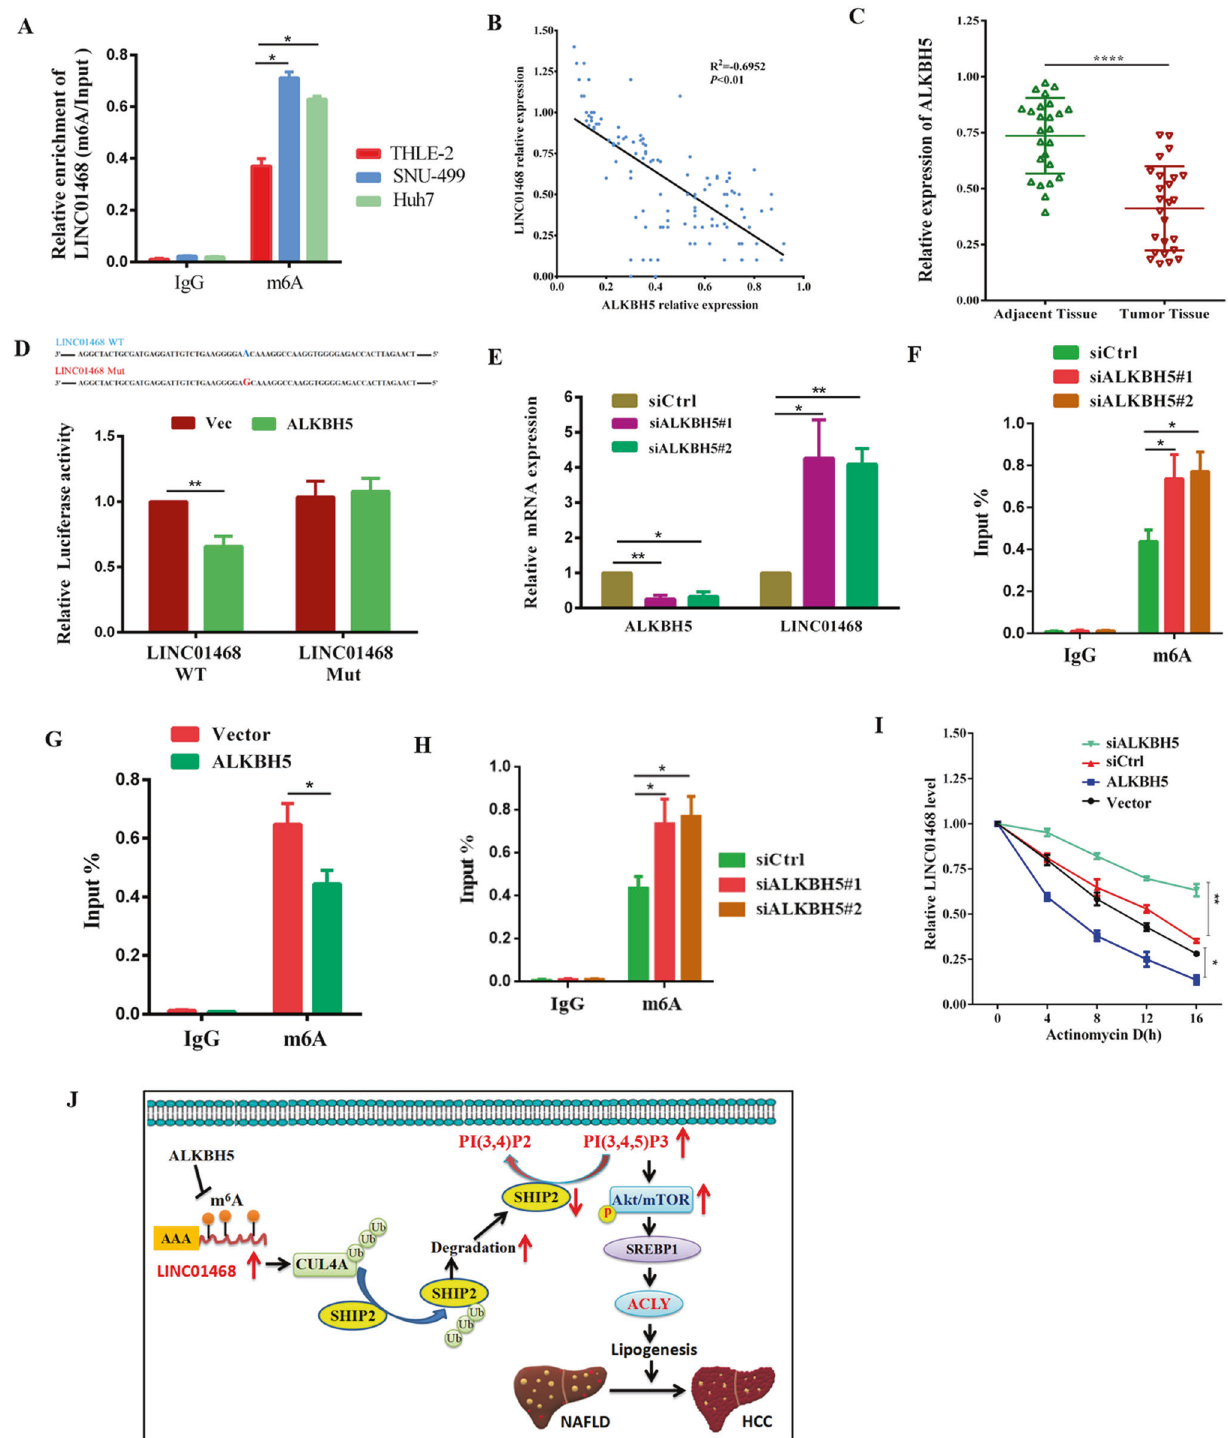
DISCUSSION The carcinogenic pathways leading to HCC tumorigenesis in NAFLD patients are complex and poorly understood. Epigenetics has been implicated in the etiology of NAFLD-associated HCC [43, 44], and the role of lncRNAs in several NAFLD-associated cancer-related processes participating in HCC tumorigenesis, such as epigenetic regulation and cell metabolism, has